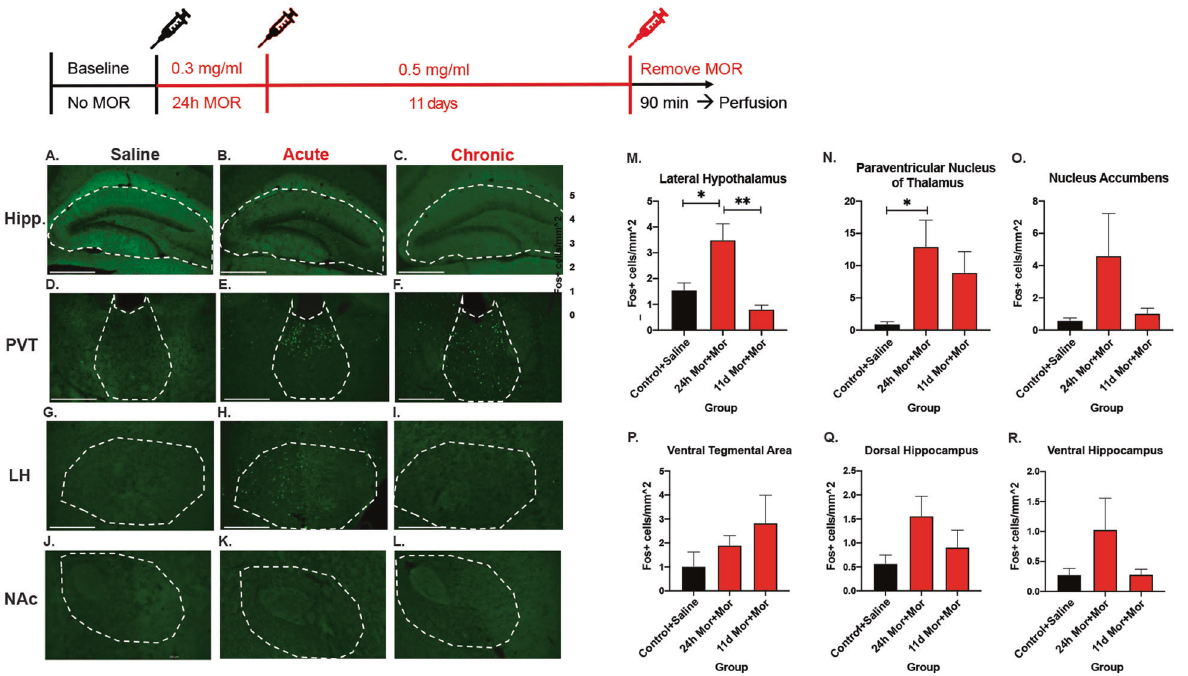
Fig. 3 Screen of immediate early gene expression across brain regions. A Representative image of hippocampus from saline group. B Hippocampus from acute morphine group. C Chronic morphine hippocampus. D Representative image of PVT (paraventricular nucleus of the thalamus) from saline group. E PVT from acute morphine group. F Chronic morphine PVT. G Representative image of LH (lateral hypothalamus) from saline group. H LH from acute morphine group. I Chronic morphine LH. J Representative image of NAc (nucleus accumbens) from saline group. K NAc from acute morphine group. L Chronic morphine LH. M Quanti fi cation of cFOS expression in LH across morphine timepoints. N cFOS expression in PVT across morphine timepoints. O cFOS expression in NAc quanti fi ed across morphine timepoints. P Quanti fi cation of cFOS expression in VTA across morphine timepoints. Q cFOS expression levels in Dorsal Hippocampus across morphine timepoints. R cFOS expression in ventral hippocampus at control, acute, and chronic morphine. Images were taken at 10× quanti fi cation and scale bars represent 500